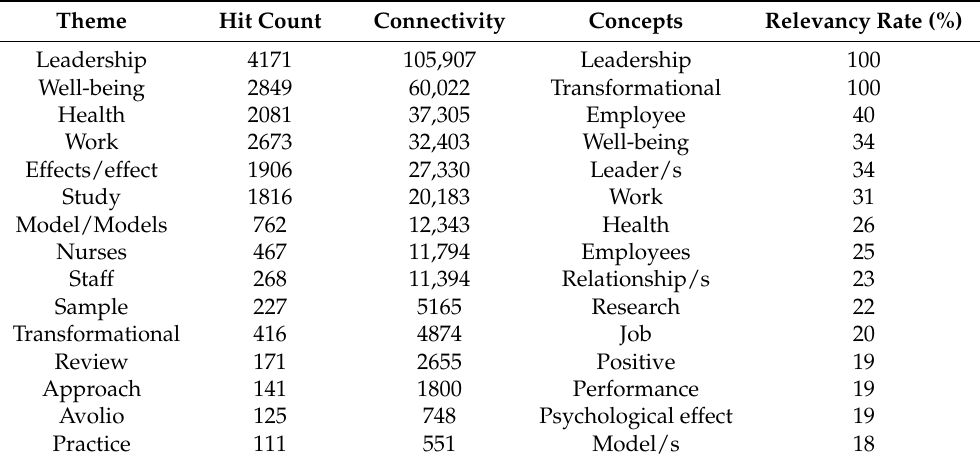
Table 1. Thematic and conceptual analysis results from the selected articles on transformational leadership and psychological